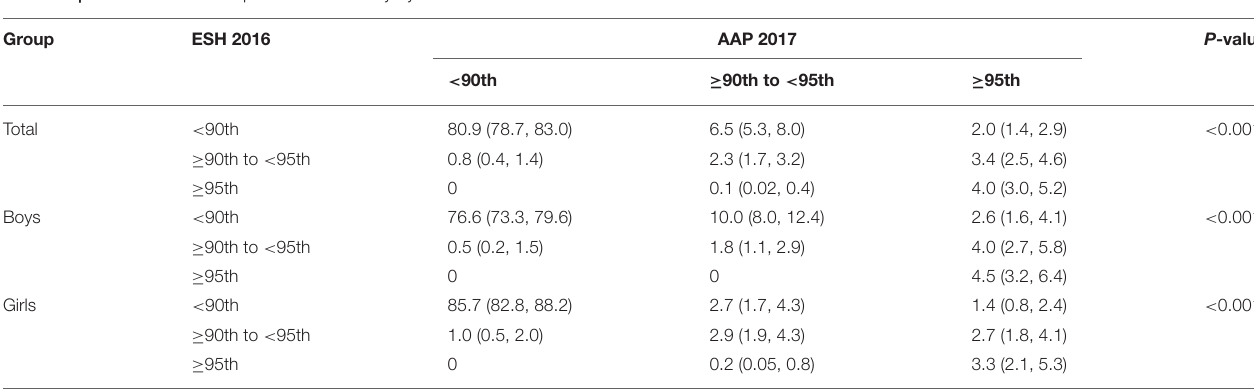
TABLE 3 | Distribution of blood pressure of catetory by sex and